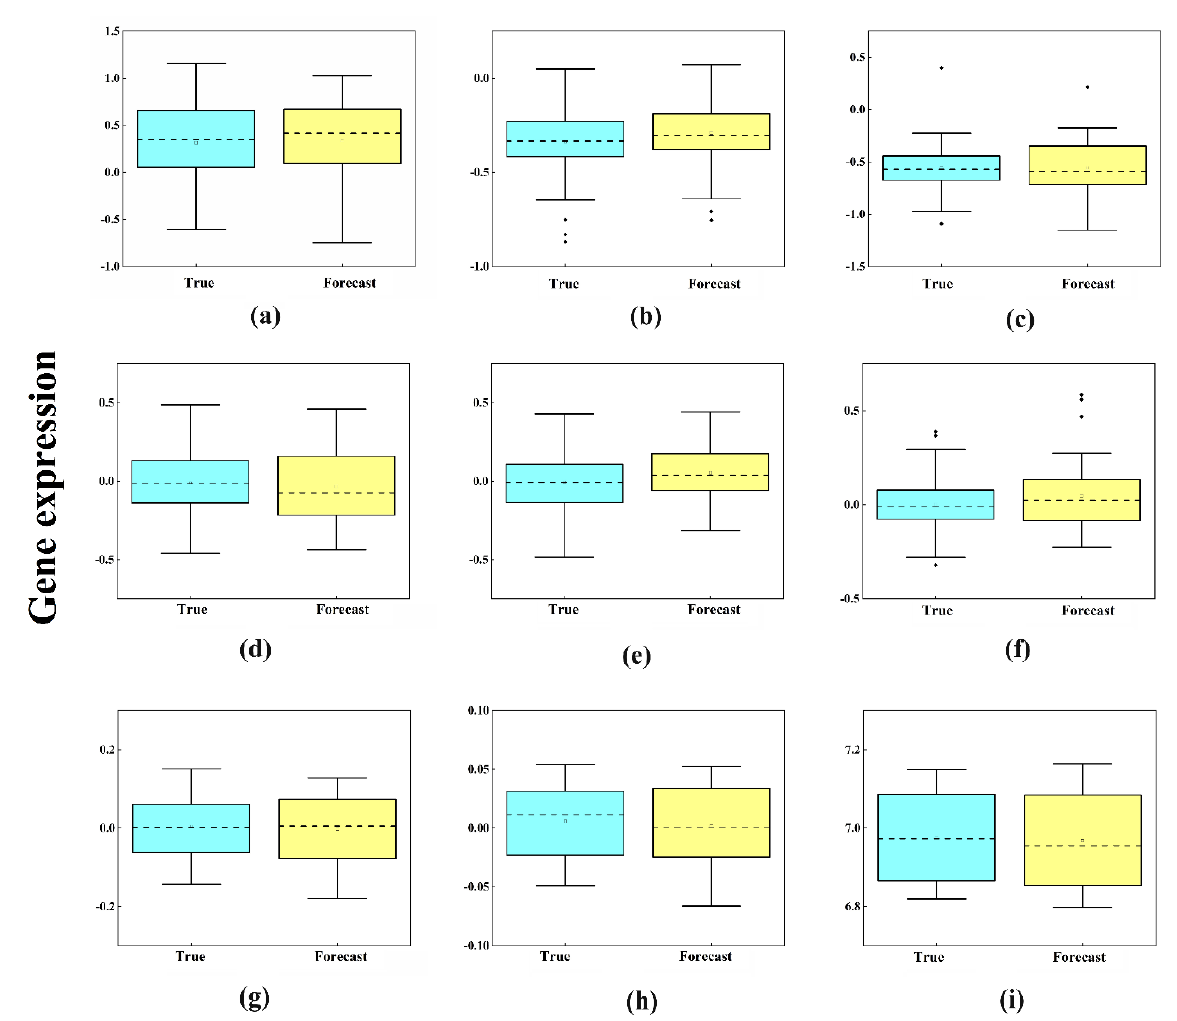
Figure 4. Proximity between the predicted values and the original data. ( a – i ) correspond to the results of components IMF 1 -IMF 9 , respectively. The results show that there is no difference between the predicted and true values of each component, and all p -values > 0.05.